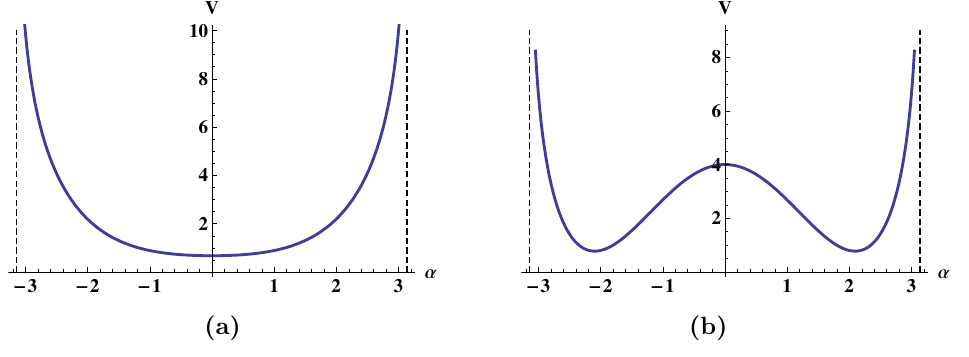
Figure 7 . Potential. (a) (cid:28) = 2 ; (cid:21) = (cid:0) 3, corresponding to region VI with (cid:21) < (cid:21) cr . (b) (cid:28) =